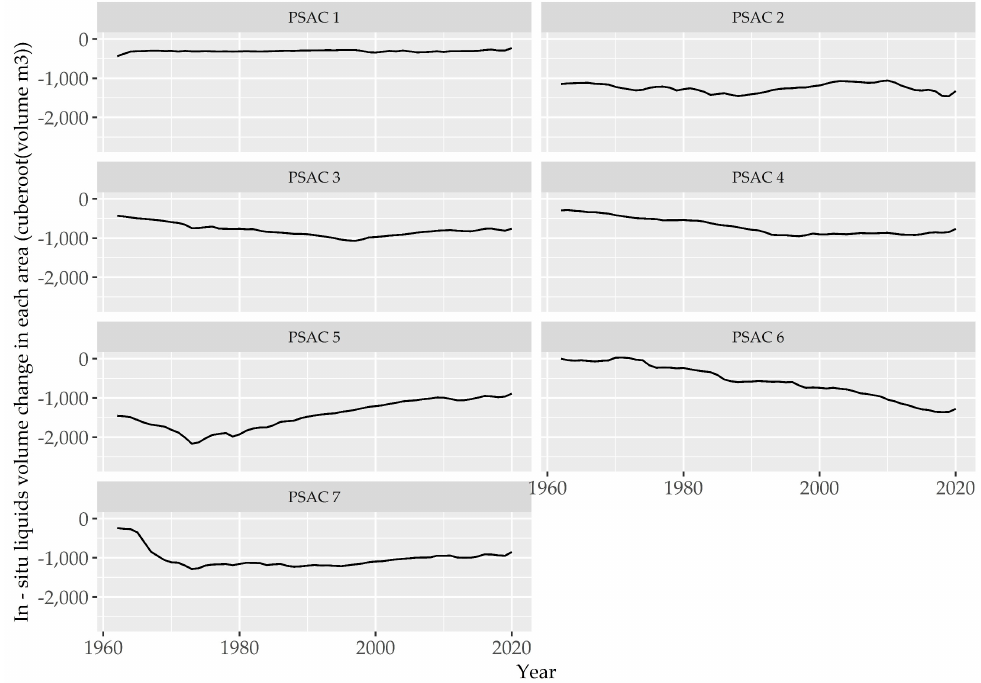
Figure 12. Calculated net annual liquid balance trend in the Alberta Basin. Source data extracted from geoLOGIC Systems databases © 2020.